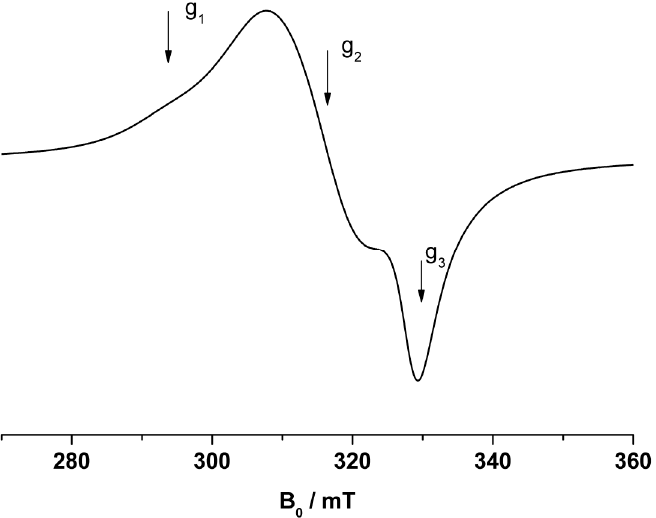
Figure 7. EPR spectrum of (C 12 H 25 Me 3 N) 2 [CuBr 4 ] ( 9 ) at 110 K.